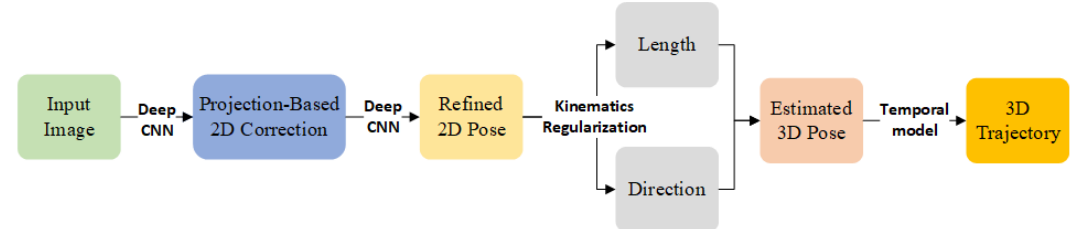
Figure 5. Illustration of Xu’s approach based on kinematics analysis.